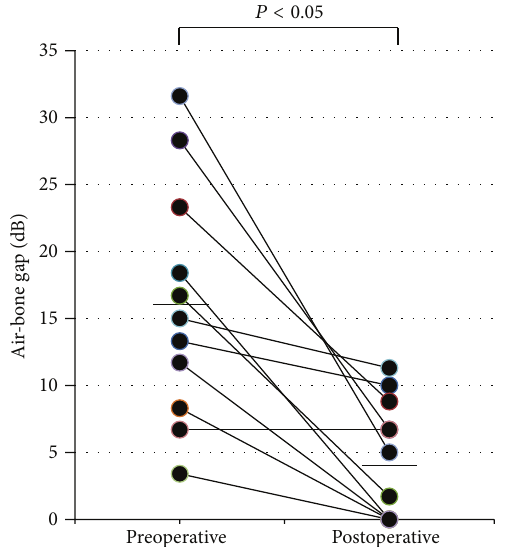
Figure 3: Scatterplots of air-bone gaps at preoperative and post- operative stages. Significant reduction is observed after surgery. Horizontal bars denote averages for each